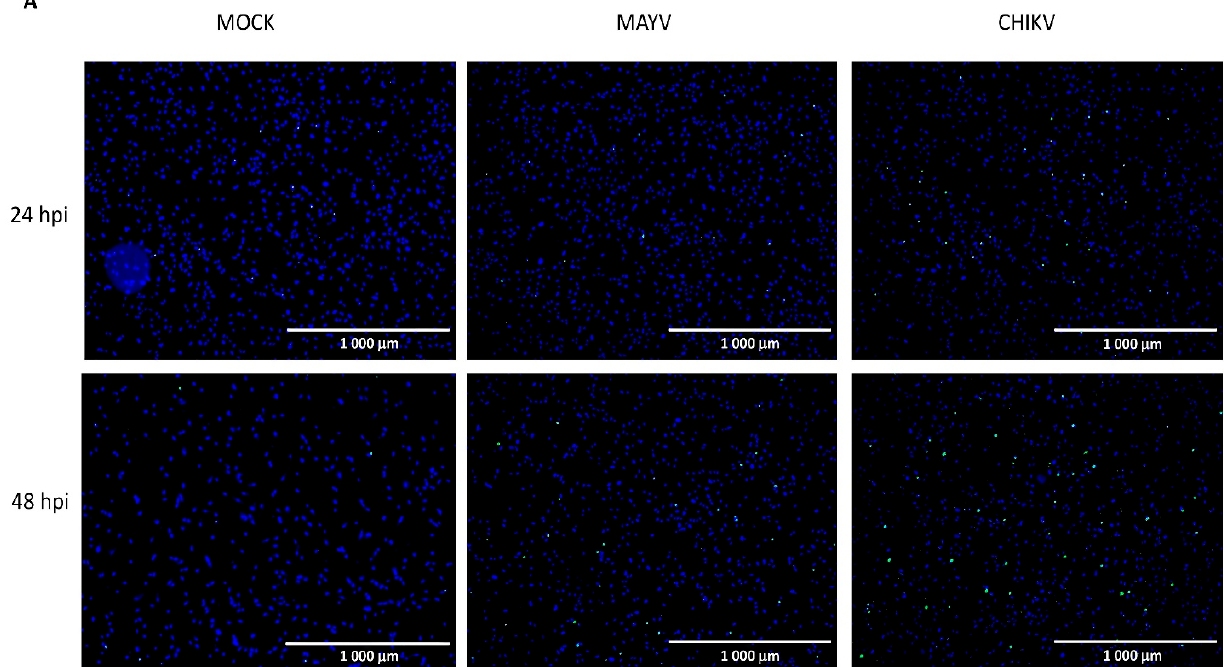
Figure 5. Cell death in primary human astrocytes following MAYV and CHIKV infection. ( A ) Live and dead cells were stained with NucBlue ® Live reagent (blue) and NucGreen ® Dead reagent (green) after infection with MAYV or CHIKV at MOI 5 at 24 and 48 hpi. Mock-infected cells were used as control. ( B ) Percentage of cell death. Mean values are represented. One-way ANOVA with Bonferroni’s post hoc test was performed. ** represents p < 0.005, **** represents p < 0.0001. The error bars represent the difference in the numbers of apoptotic cells counted in three fields. An average number of three fields were counted in the experiment ( n = 2).